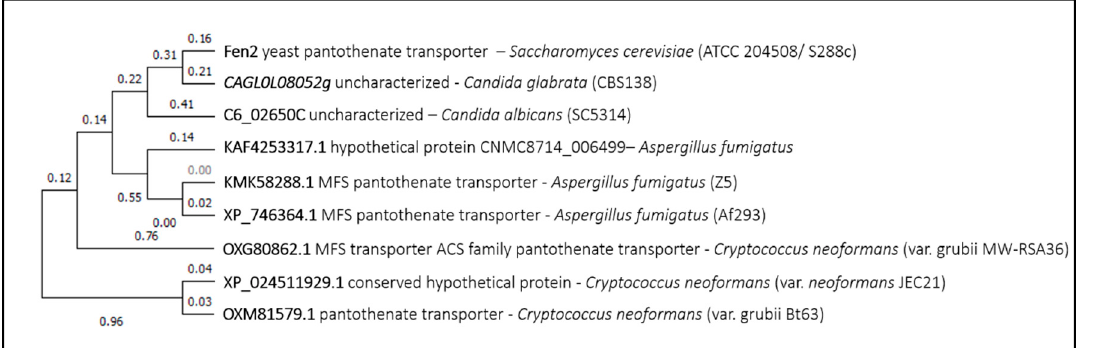
Figure 3. Fen2 phylogenetic analysis. The tree with the highest log likelihood is shown. This analysis involved nine amino acid sequences. There were a total of 650 positions in the final dataset. Evolutionary analyses were conducted in MEGA X.